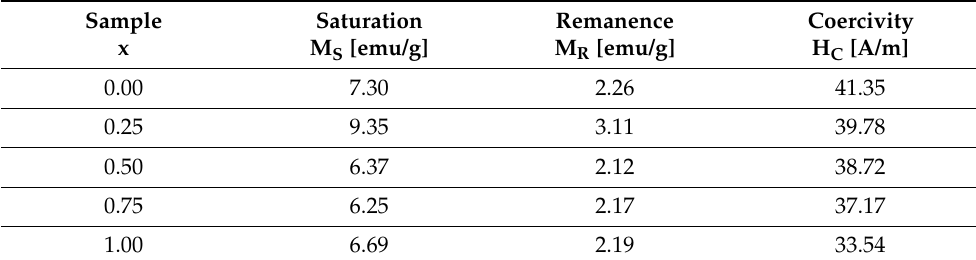
Figure 5. Magnetic hysteresis loops obtained for investigated multiferroic perovskite samples. Table 2. Summary of themagnetic properties of Al 1-x Sb x FeO 3 perovskites.